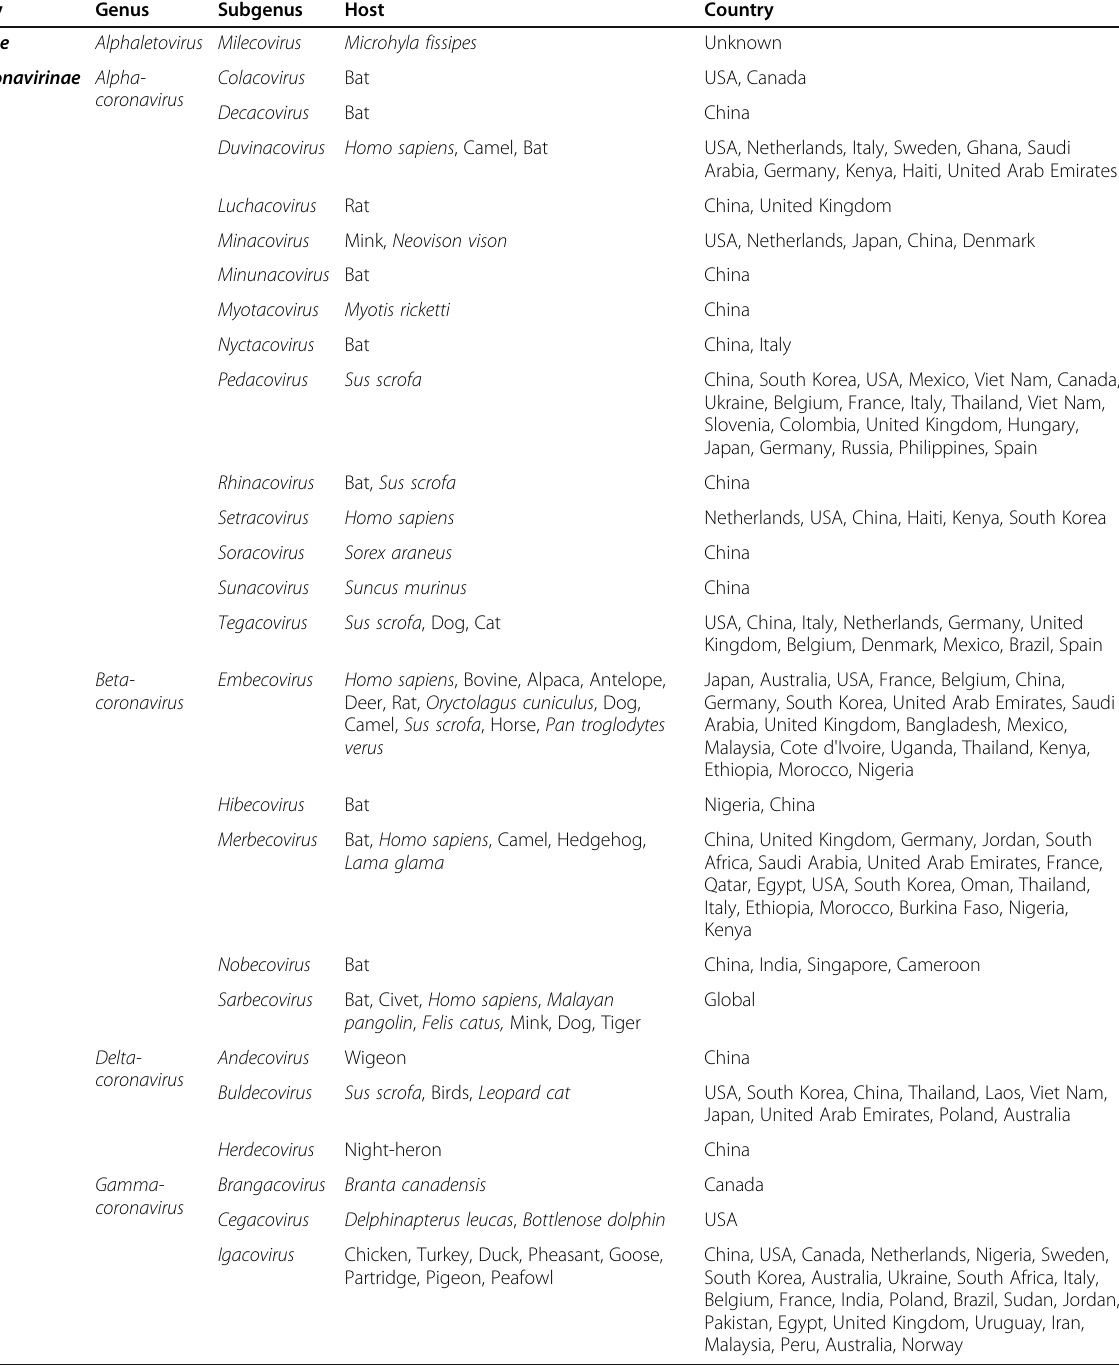
Table 1 Hosts and sampled countries for Cornidovirineae viruses Subfamily Genus